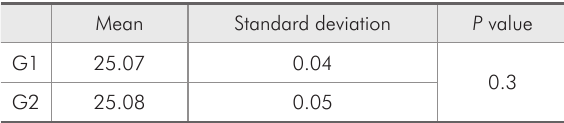
Table. 3. - Descriptive statistics for dimensional stability (mm).